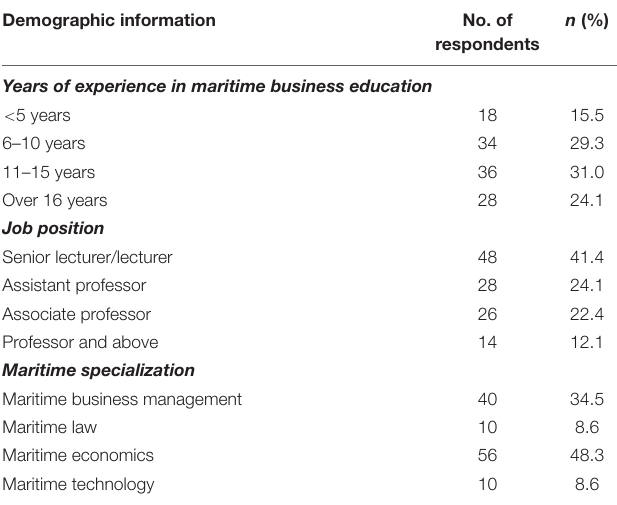
TABLE 4 | Demographic characteristics of respondents ( n =